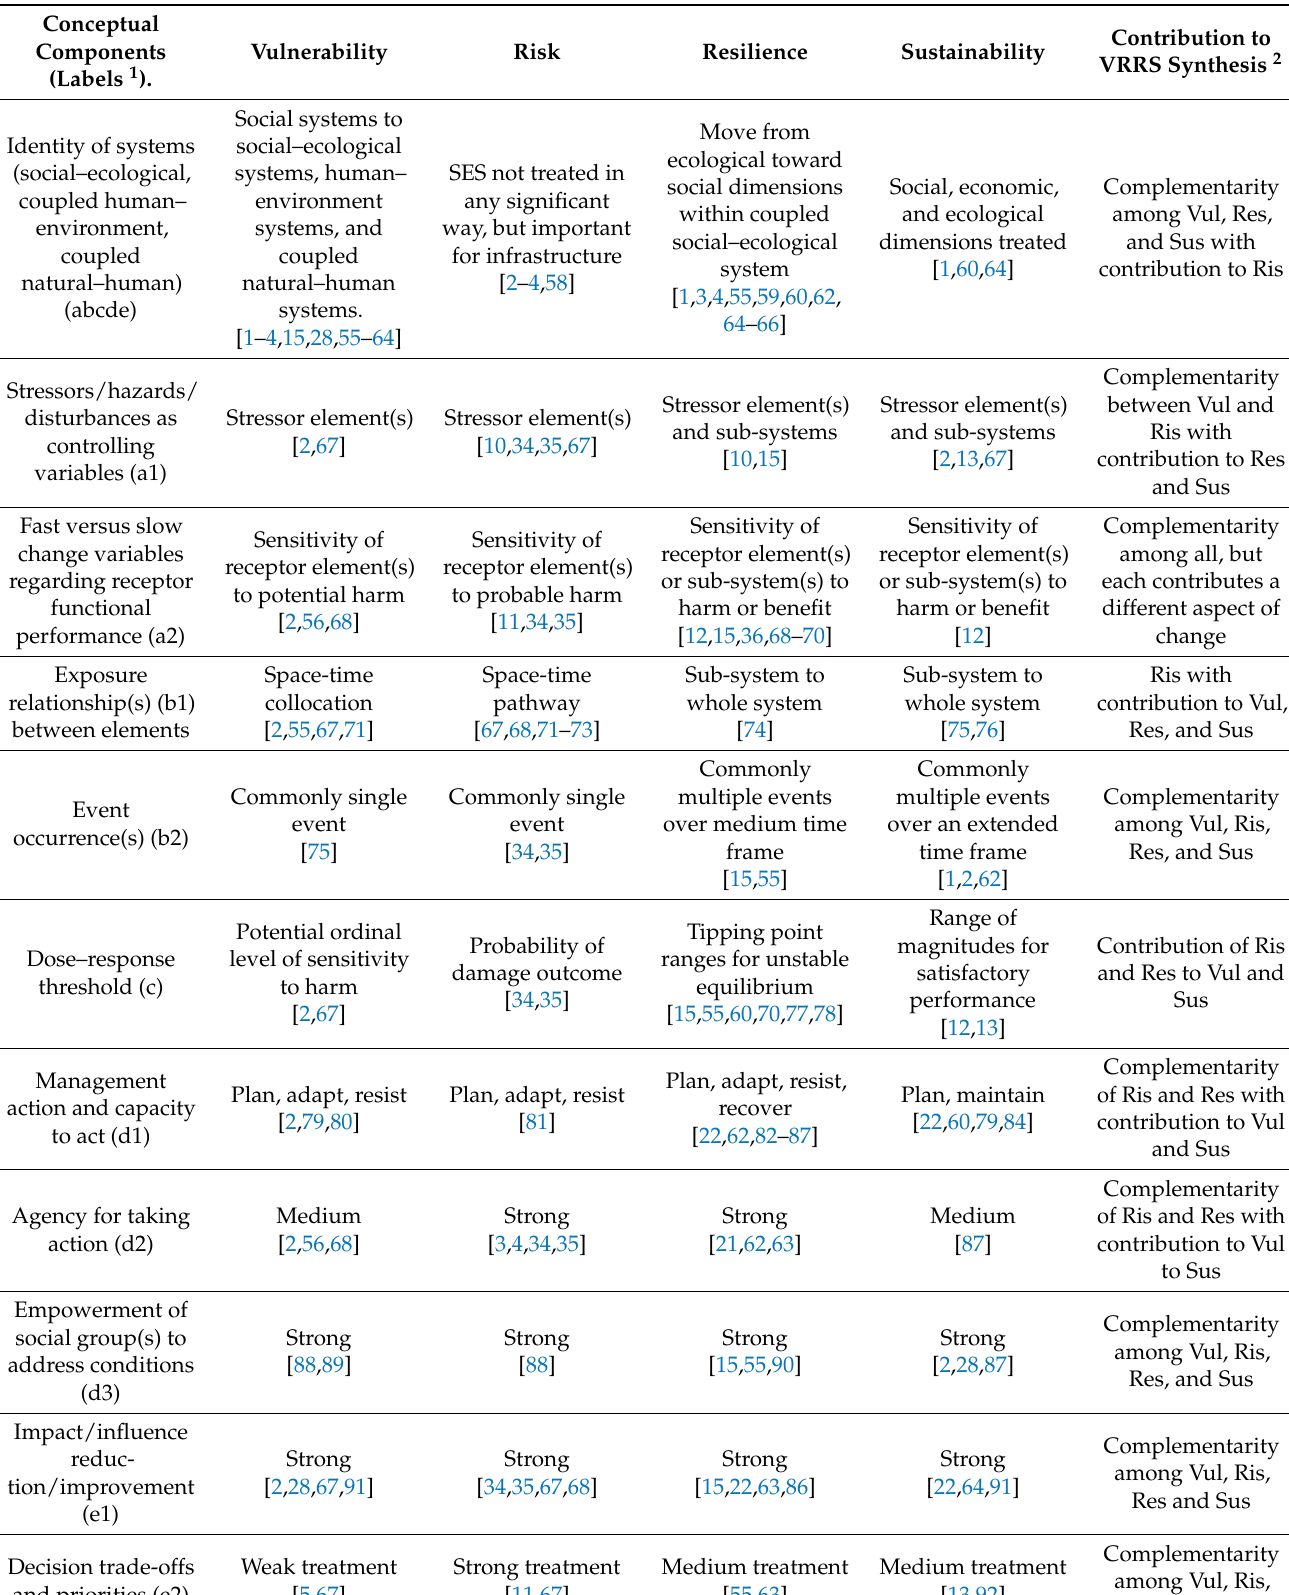
Table 2. Conceptual components and their relevance within a VRRS